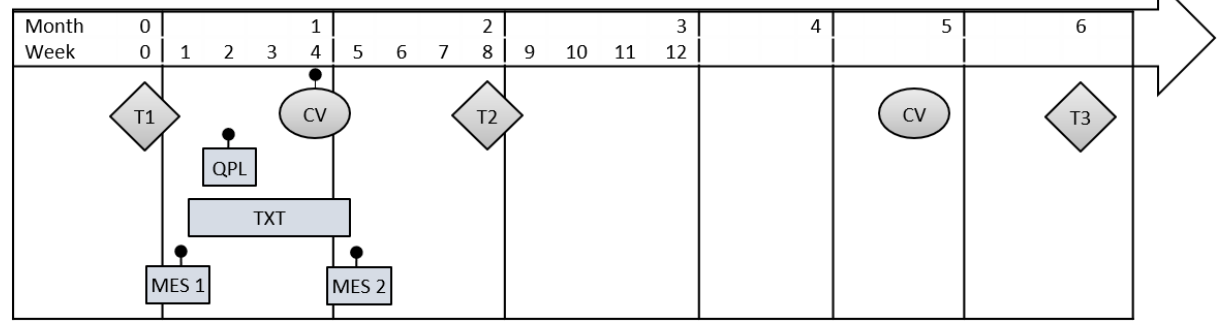
Figure 4. Participant timeline. CV: clinic visit; MES: motivation enhancement system; QPL: question prompt list; T: time; TXT: text message